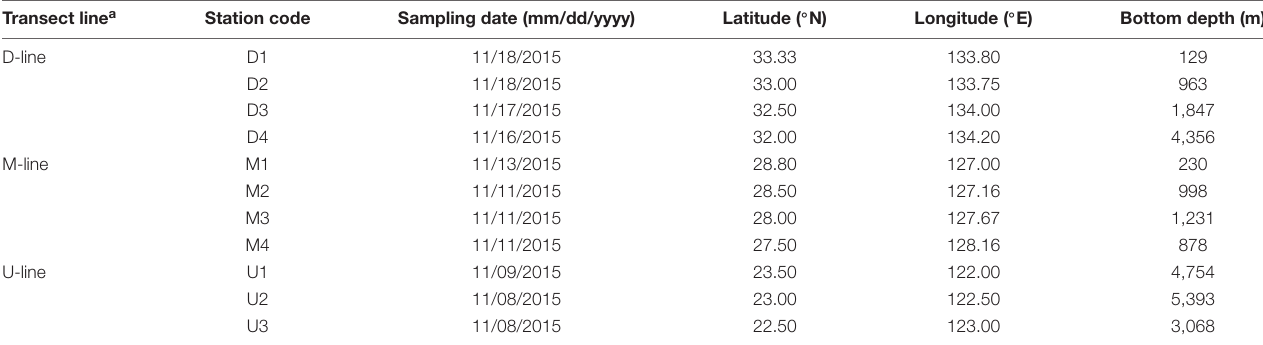
TABLE 1 | Locations of sampling stations deployed during the KH-15-4